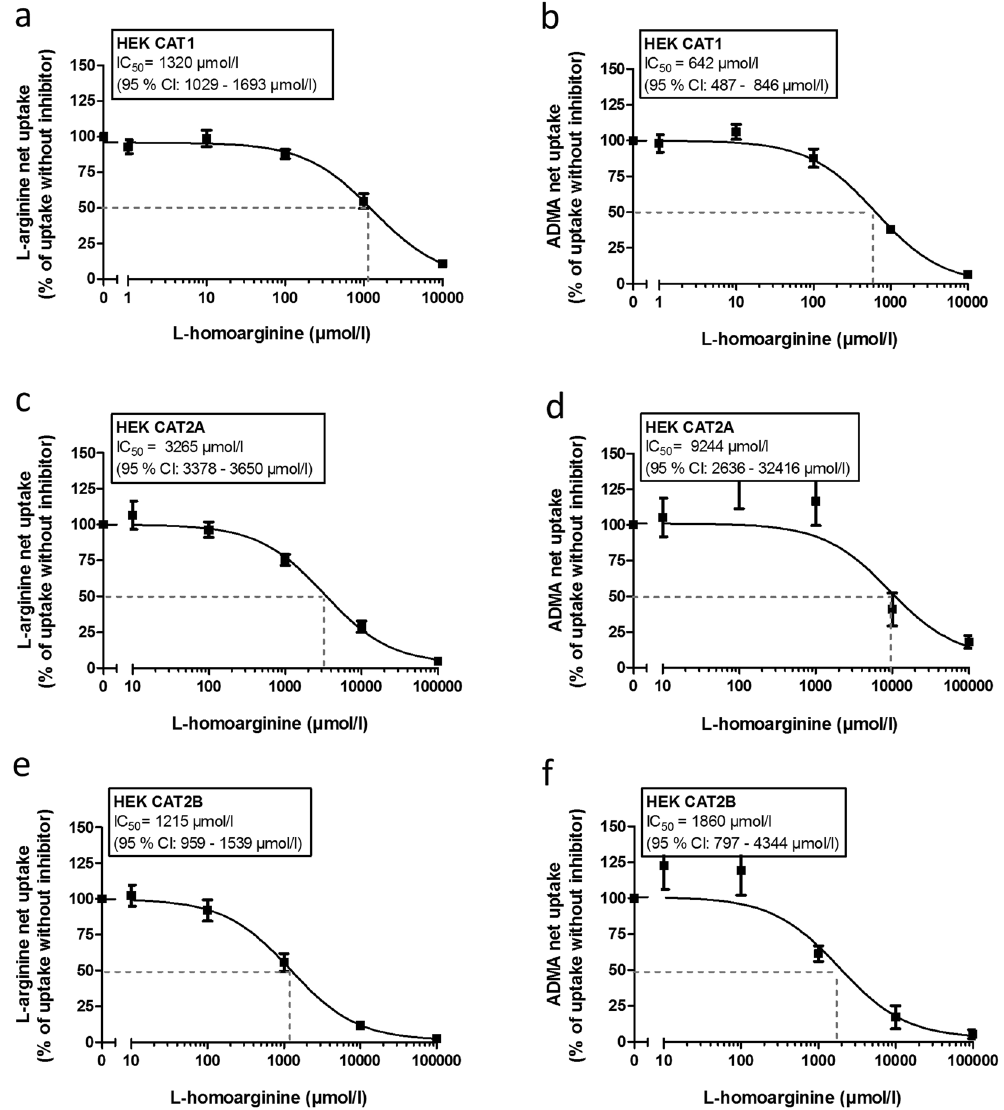
Figure 6. Inhibition of CAT1-, CAT2A-, CAT2B-mediated L-arginine ( a , c , e ) and ADMA ( b , d , f ) uptake by increasing concentrations of L-homoarginine. Each data point is n =